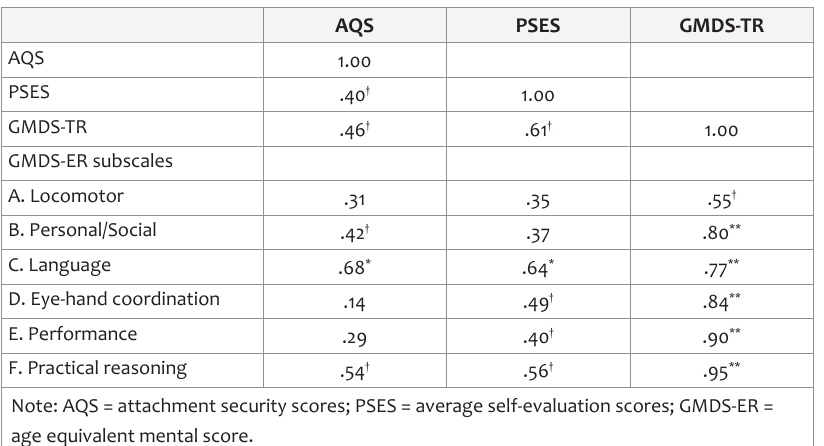
Table 2: Spearman’s Correlation ( r